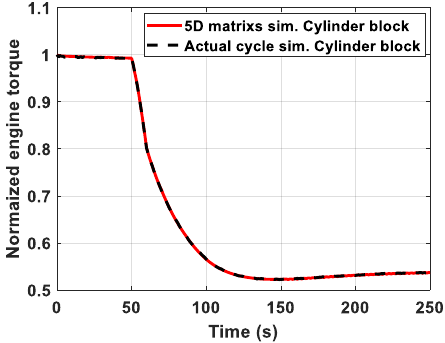
Figure 23. Engine torque time history.